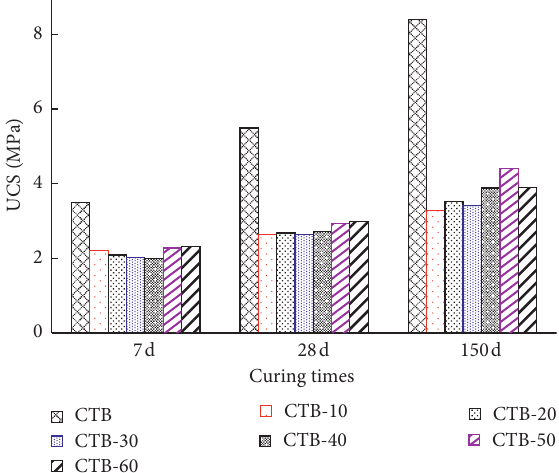
Figure 4: UCS of CTB samples with slag of different grinding times.